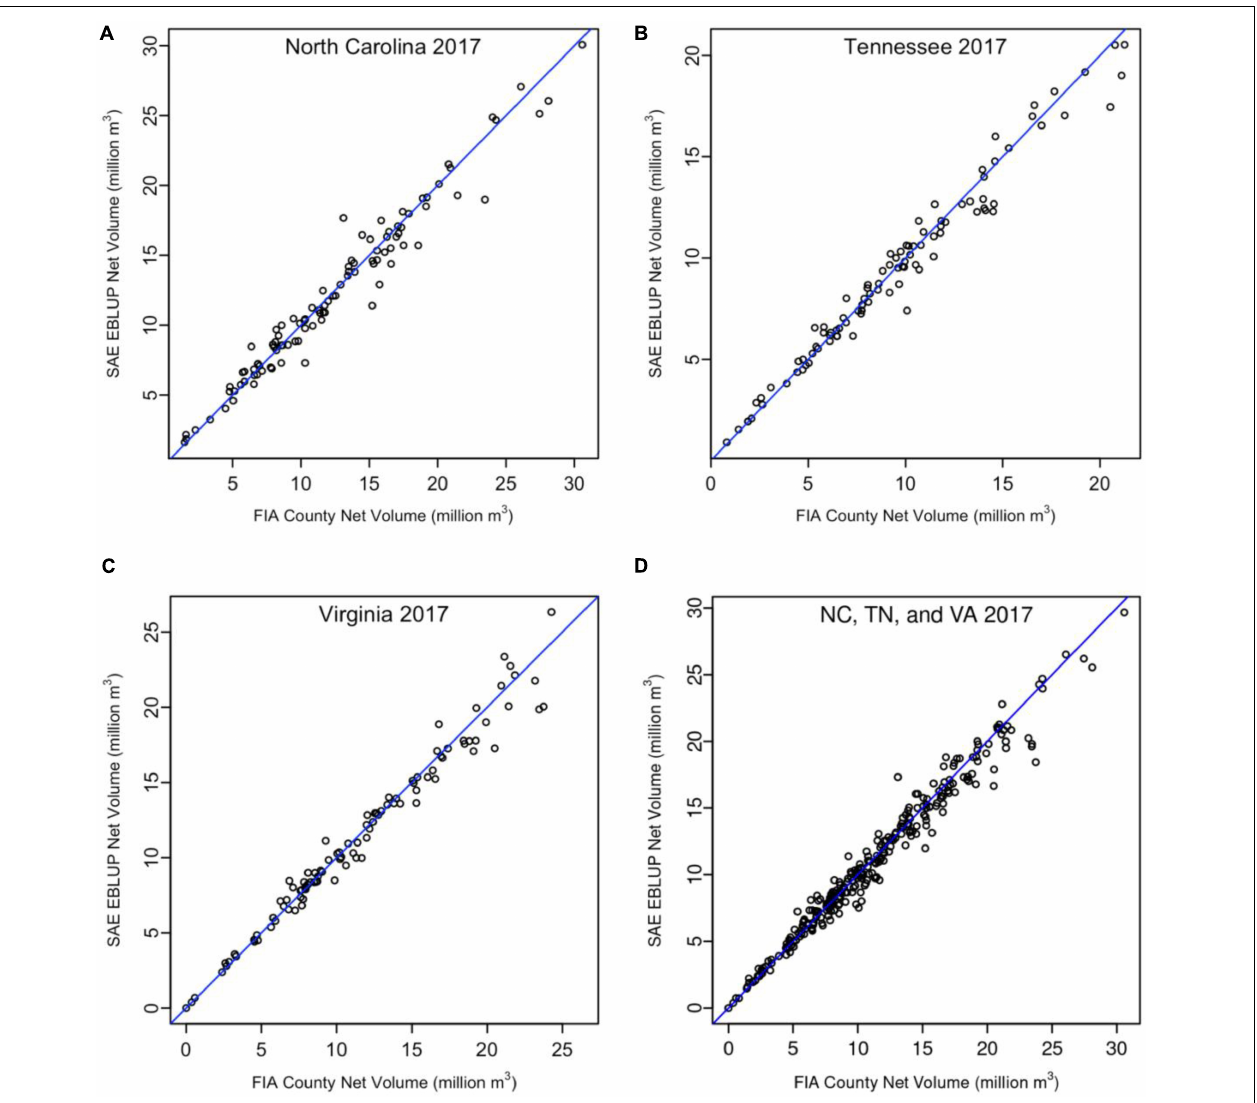
FIGURE 1 | Fay Herriot composite estimates (EBLUP) of county forest volume totals compared to FIA direct estimates for three separate state-level analyses (A–C) and the combined 3-state SFH analysis (D)